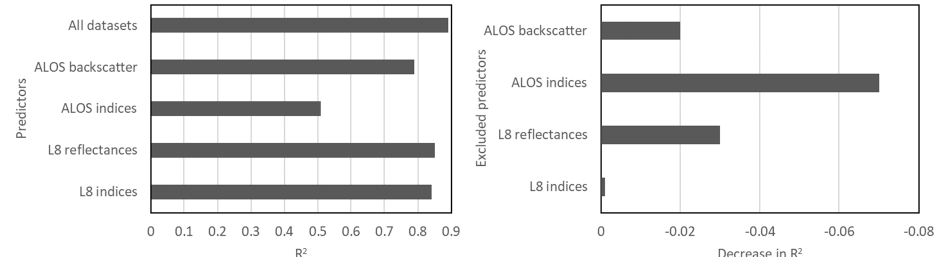
Figure 5. Averaged variable importance analysis across the k-fold procedure for each set of variables derived from Landsat 8 (L8) and ALOS-2/PALSAR-2 (ALOS) included in the random forest (RF) model. The R 2 for each single set of variables and all variables together (left) and decrease in R 2 for models excluding a single set of variables (right). ALOS backscatter: 𝛾 (cid:3009)(cid:3023)(cid:2868) and 𝛾 (cid:3009)(cid:3009)(cid:2868) . ALOS indices: radar forest degradation index (RFDI), cross-polarised ratio (CpR). L8 reflectances: blue, green, red, near infrared, shortwave infrared-1, and shortwave infrared-2. L8 indices: normalised difference vegetation index (NDVI), normalised burn ratio (NBR), NBR2, normalised difference moisture index (NDMI), and soil adjusted vegetation index (SAVI).